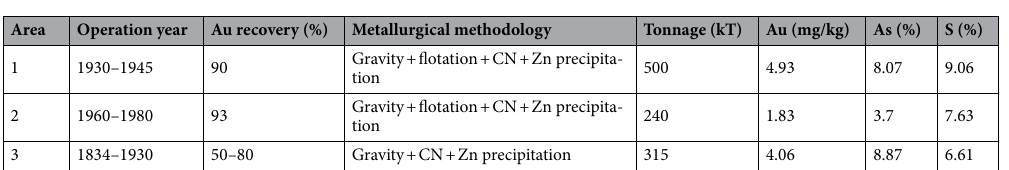
Table 1. Forms of Au extraction, mass estimates and concentrations of Au, As, and S for deposits 1, 2, and 3 (modified from 53 ).